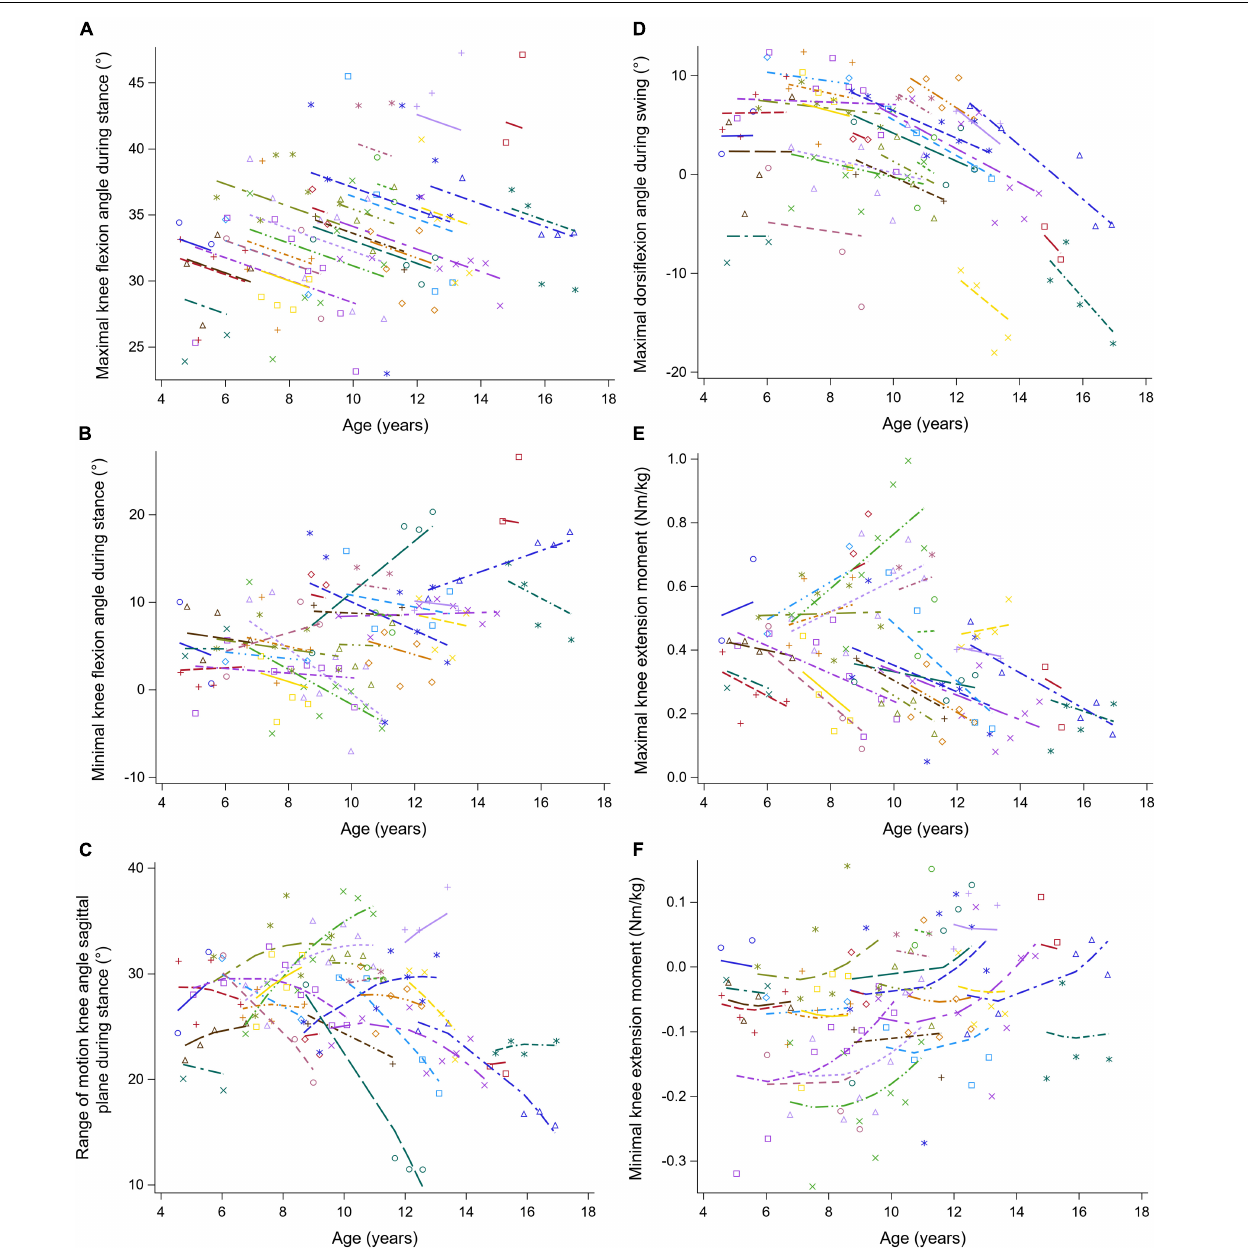
FIGURE 6 | The individual predicted profiles (dashed lines) for the maximal knee flexion angle during stance (A) , minimal knee flexion angle during stance (B) , range of knee motion in sagittal plane during stance (C) , maximal knee flexion angle during swing (D) , maximal knee extension moment (E) , and minimal knee extension moment (F) . The actual observed values are visualized by the symbols. Each color represents one patient with DMD. The regression coefficients of the fixed effects are given in Table 6 . DMD, Duchenne muscular